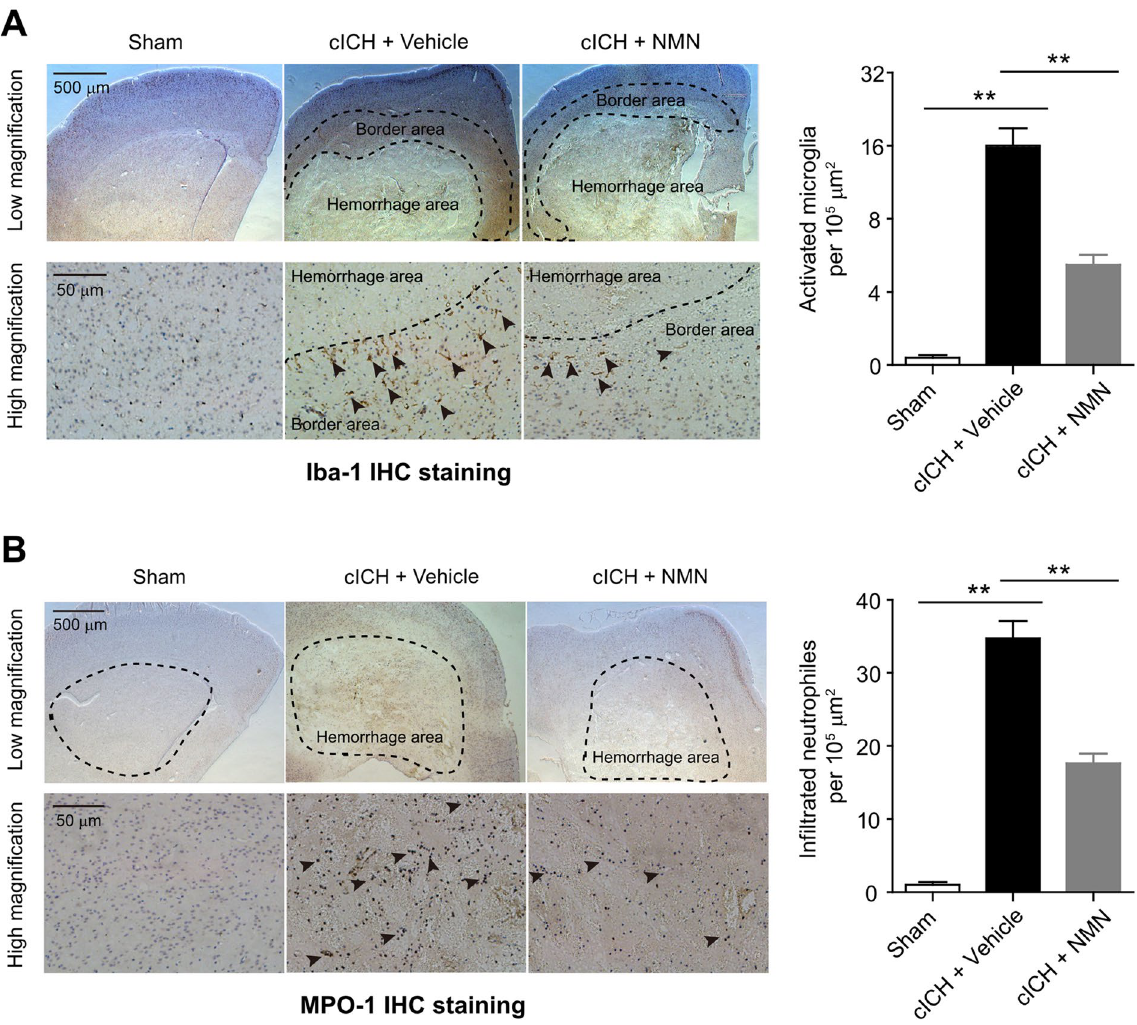
Figure 3. Effects of NMN on microglia activation and neutrophil infiltration in mouse cICH model. ( A ) Representative images and quantitative analysis of Iba-1 (microglia marker) immunohistochemistry staining at 24 hours post cICH. ** P < 0.01, n = 5 per group. ( B) Representative images and quantitative analysis of MPO-1 (neutrophil marker) immunohistochemistry staining at 24 hours post cICH. ** P < 0.01, n = 5 per